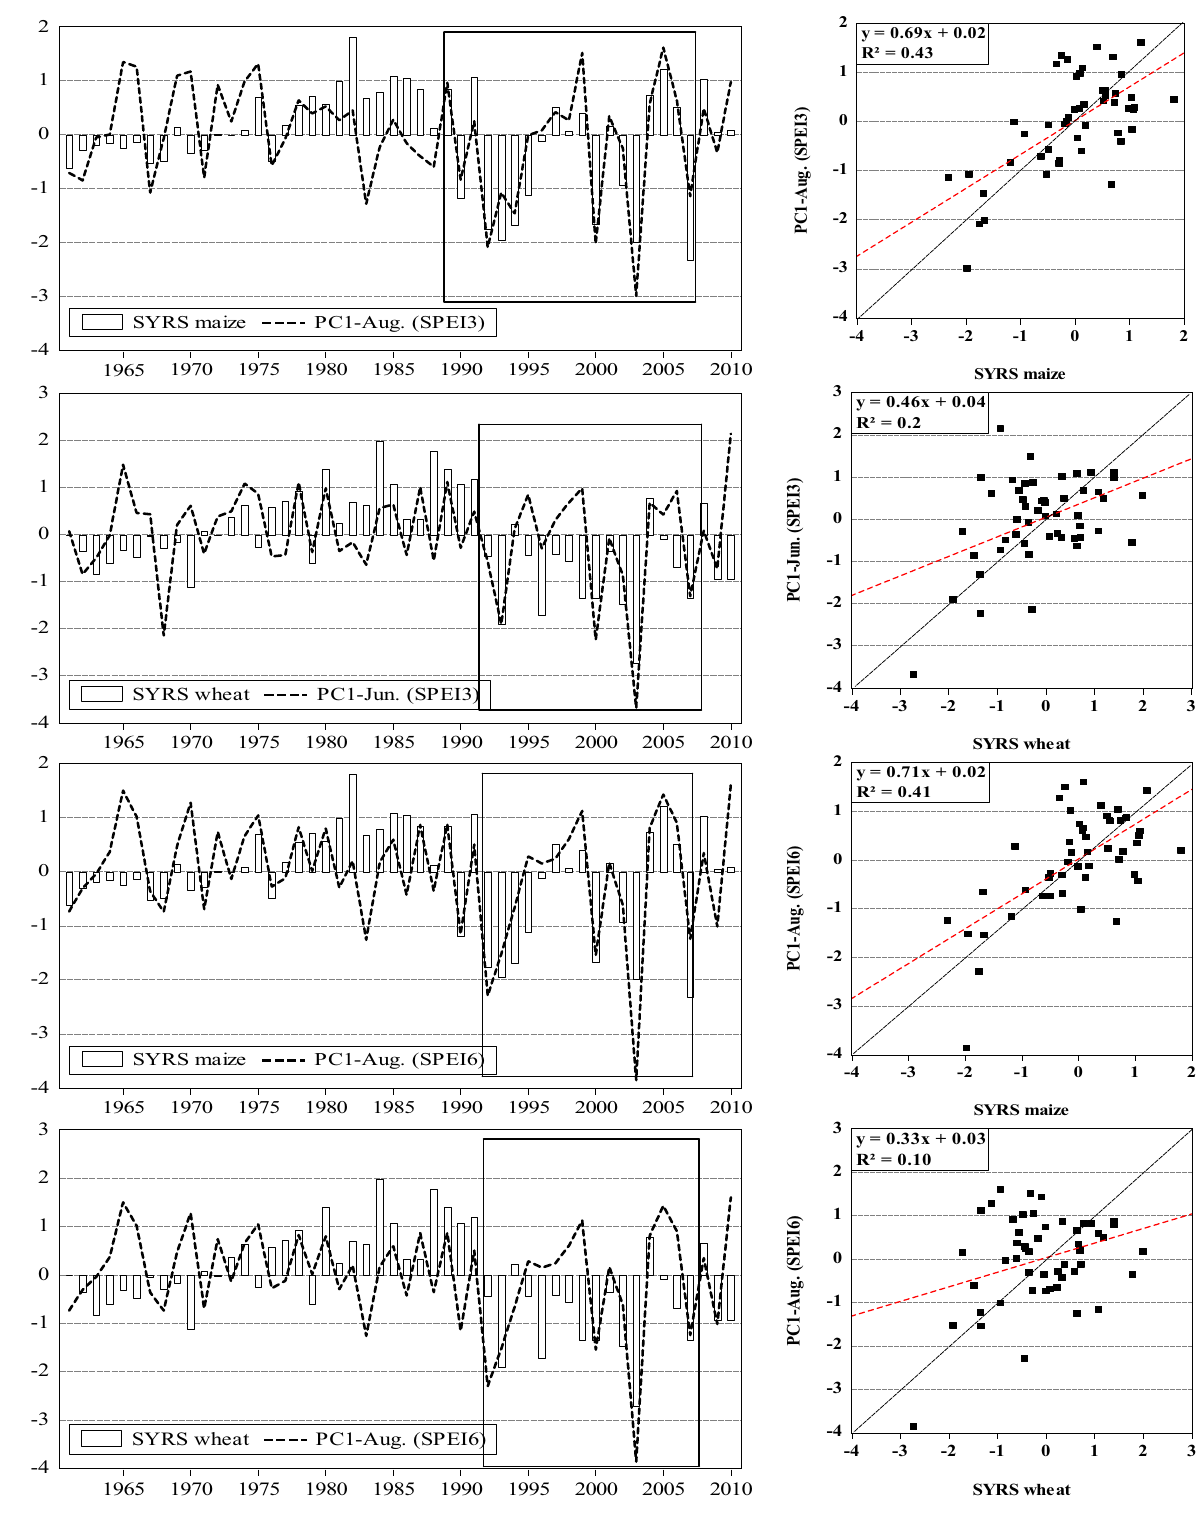
Figure 13. Drought loading (PC1) vs. SYRS for maize and wheat across Hungary (1961–2010) (figure was generated using EViews (https:// www. eviews. com/ home.